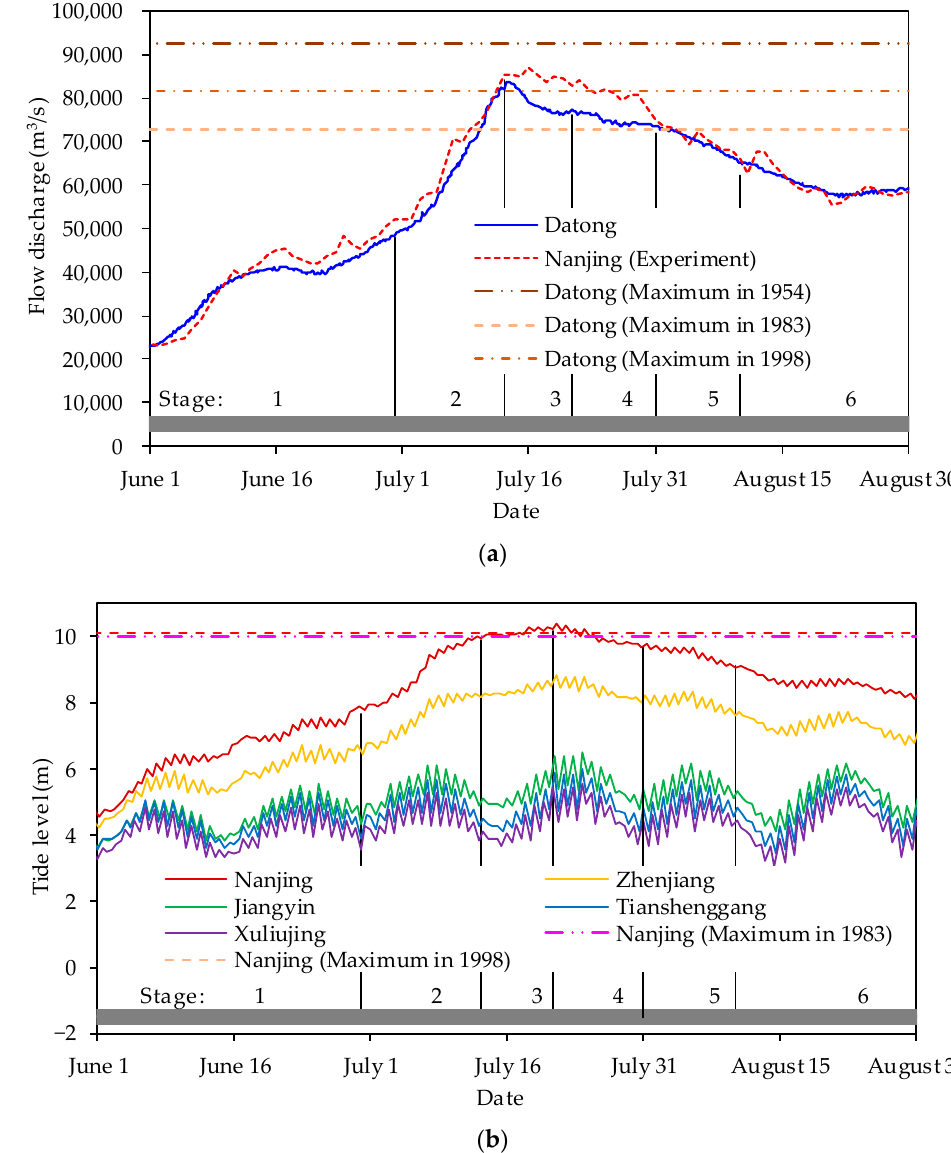
Figure 2. Flood process below Datong: ( a ) flood discharge; ( b ) high tide level.